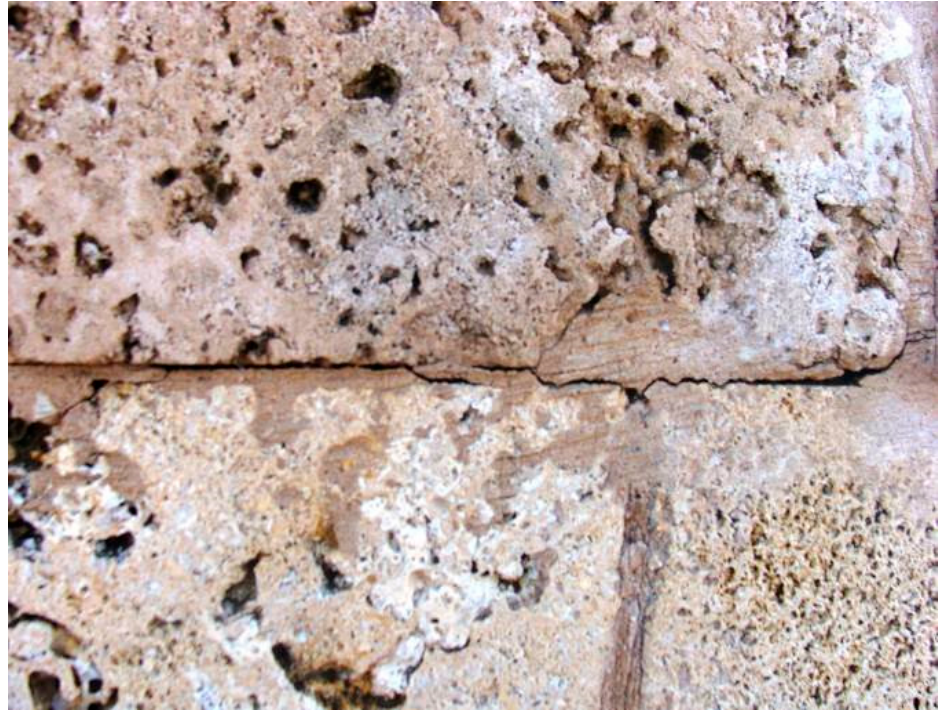
Figure 7. Weathering out of stone components in the Panorama sea walls. Captured by the author on 27 November 2018.